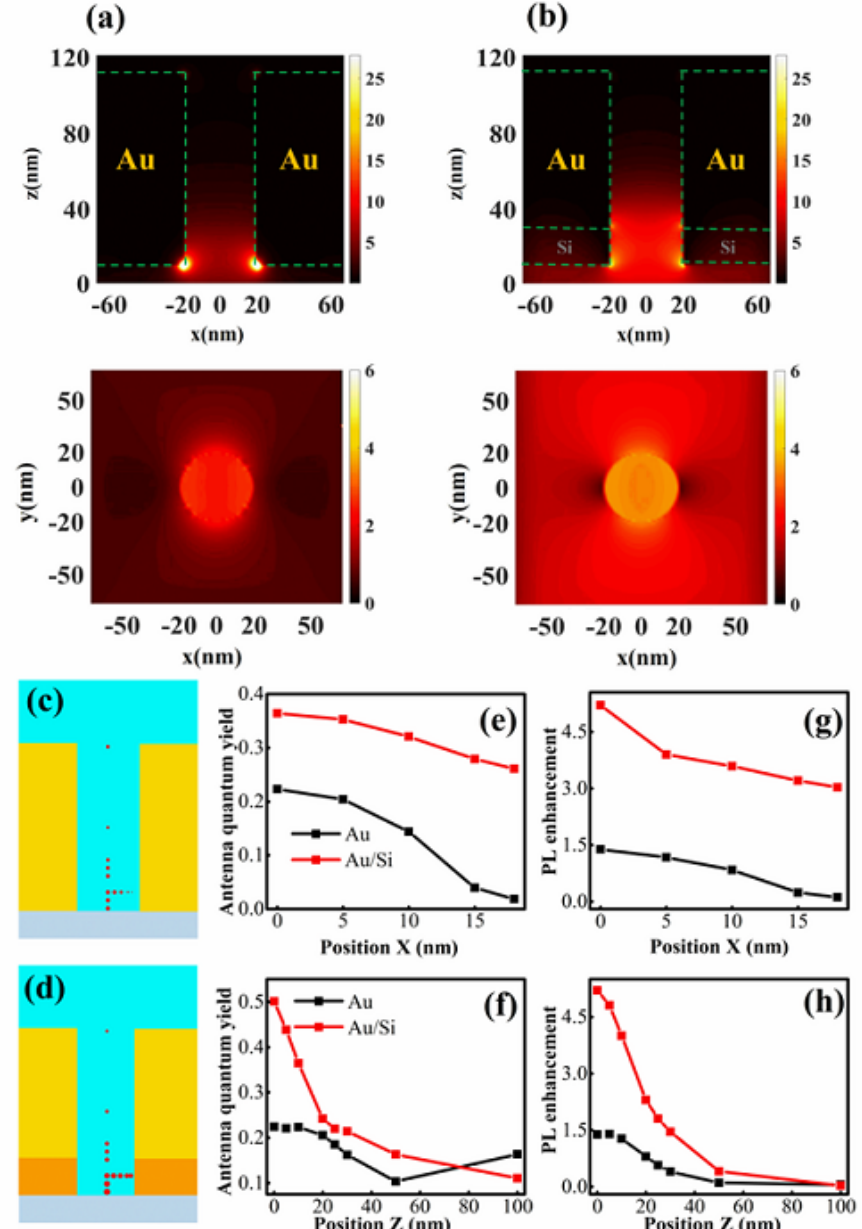
Figure 2. Electric field distribution |E/E 0 | 2 in the xz -plane and xy -plane for ( a ) Au nano-aperture antenna at 573 nm and ( b ) Au/Si hybrid nano-aperture antenna at 785 nm illuminated by a plan wave with x -polarization from the bottom. The position-dependent quantum yields (the sizes of red disks represent the relative value of quantum yield at the positions correspondingly) ( c ) at 660 nm for the Au nano-aperture antenna; ( d ) at 814 nm for Au/Si hybrid nano-aperture antenna; ( e , f ) show quantum yields at different x - and z -positions indicated in ( c , d ), correspondingly. Panels ( g , h ) show photoluminescence (PL) enhancements at different x - and z -positions indicated in ( c , d ),